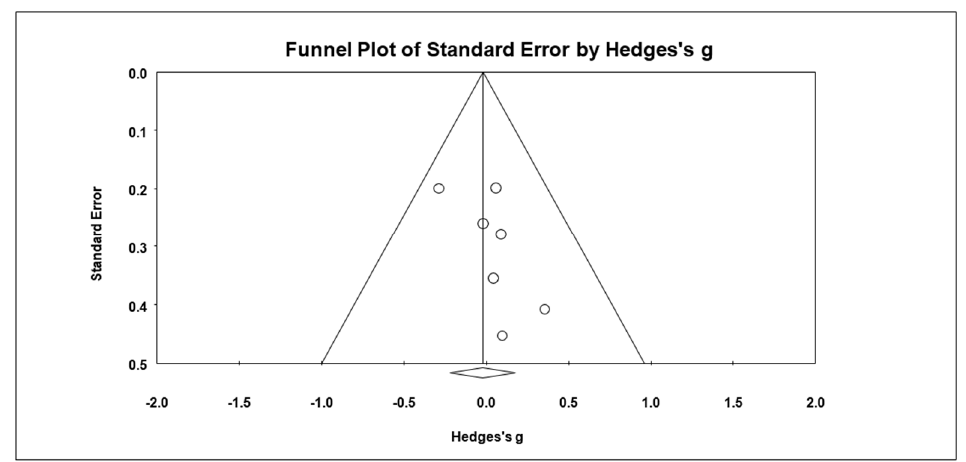
Figure 5. Funnel plot for externalizing behavioral problem.